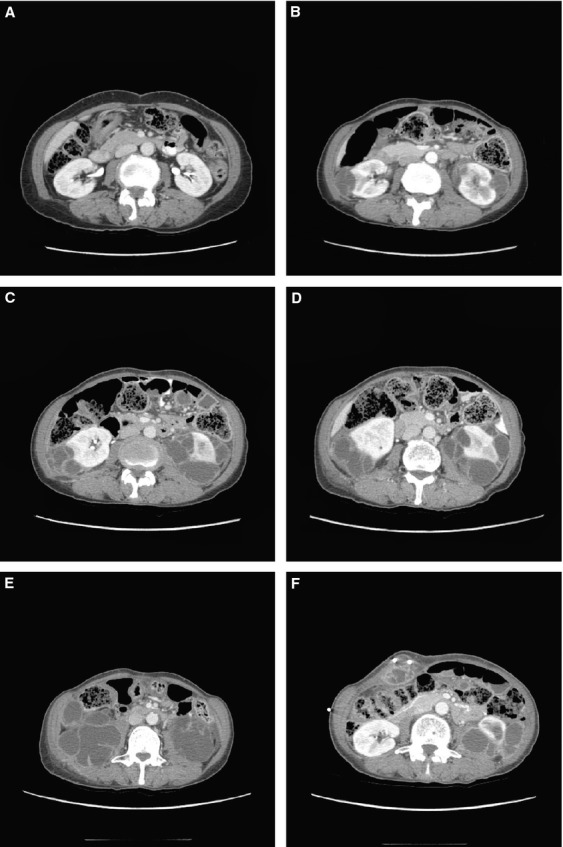
Computed tomography images of a 61-year-old woman with ALK-positive NSCLC who developed complex renal cysts during treatment with crizotinib (patient 1, Table 1). (A) baseline and (B) 2.5 months, (C) 4.1 months, (D) 5.5 months, (E) 6.3 months (just prior to cyst resection), and (F) 18.1 months after initiation of treatment. The images show progressive growth of multiseptated renal cystic lesions infiltrating the perirenal space and involving the left psoas muscle. Additionally, a cystic lesion in the anterior abdominal wall developed (drain in place, F), which was resected. Pathology showed degenerated muscular tissue with fibrosis and acute inflammation. NSCLC, non–small cell lung cancer. ALK, anaplastic lymphoma kinase.